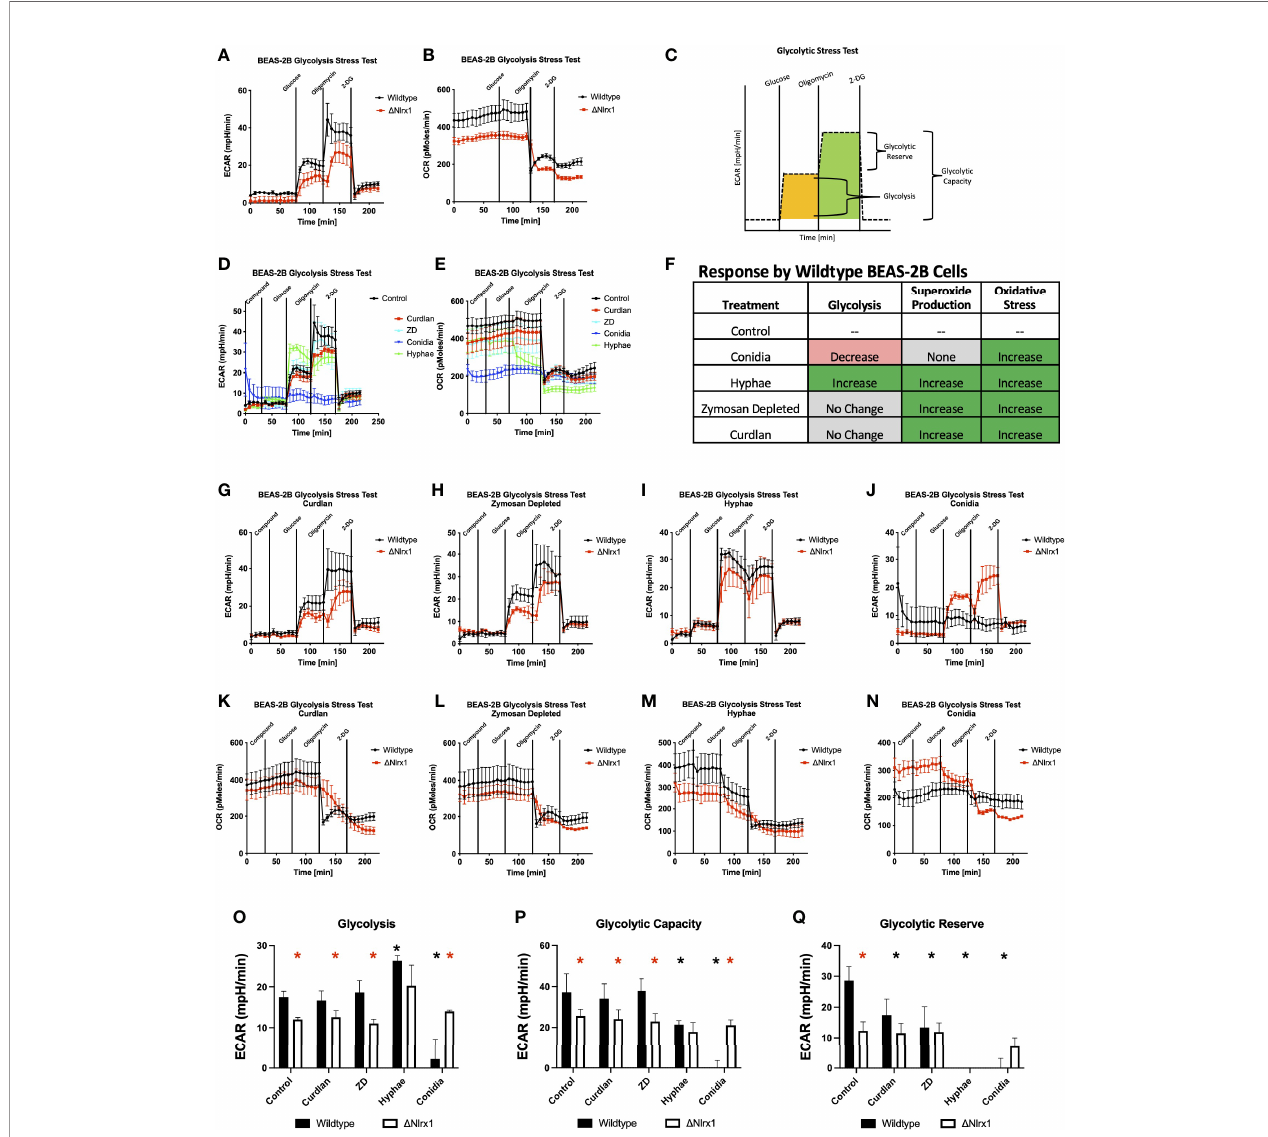
FIGURE 4 | Modulation of glycolysis within BEAS-2B in response to A. fumigatus conidia, hyphae, and a subset of fungal PAMPs is dependent on Nlrx1. (A) Extracellular acidi fi cation rate (ECAR, mpH/min) and (B) oxygen consumption rate (OCR, pmol/min) for wild-type and Nlrx1-de fi cient ( D Nlrx1) cells using a standardized glycolytic stress test outlined in (C) . Measurement of (D) ECAR and (E) OCR by wild-type BEAS-2B cells during a modi fi ed glycolytic stress test. The modi fi ed version of the assay provides an injection of fungal PAMPs (zymosan depleted and curdlan), killed hyphae, or killed conidia prior to the standard test. (F) Summary of glycolysis, superoxide production, and general reactive oxygen species production by BEAS-2B cells in response to killed conidia, hyphae, and fungal PAMPs zymosan depleted and curdlan. (G – J) ECAR and (K – N) OCR by wild-type and D Nlrx1 BEAS-2B cells during a modi fi ed glycolytic stress test using fungal PAMPs (zymosan depleted and curdlan), killed hyphae, or killed conidia. Calculated values for (O) glycolysis, (P) glycolytic capacity, and (Q) glycolytic reserve. For (O – Q) , black asterisk denotes p < 0.05 via Kruskal – Wallis test followed by a Dunn ’ s test for multiple comparisons against the control. Red asterisk denotes p < 0.05 between genotypes for a given treatment